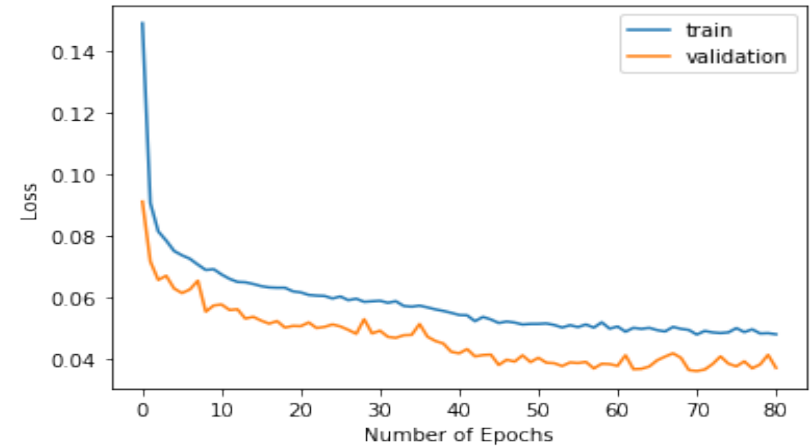
Figure 10. Model loss in training and validation phases in first layer.